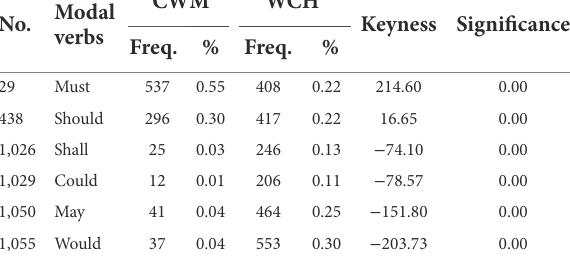
TABLE 10 Key modal verbs in SWM (in comparison with CWM).